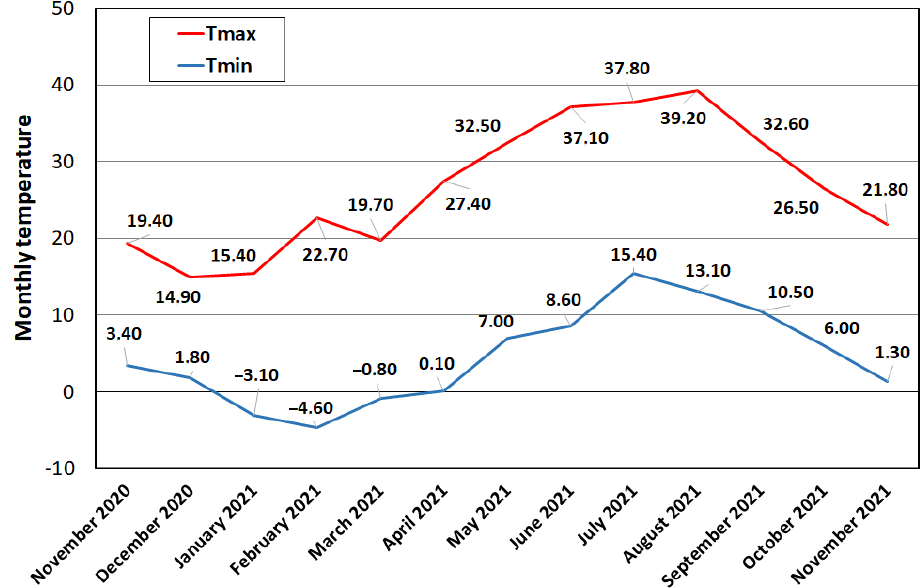
Figure 8. Maximum and minimum temperatures recorded at the Monticchio Bagni Station from